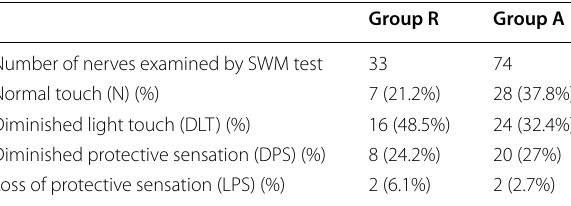
Table 1 Semmes–Weinstein monofilament